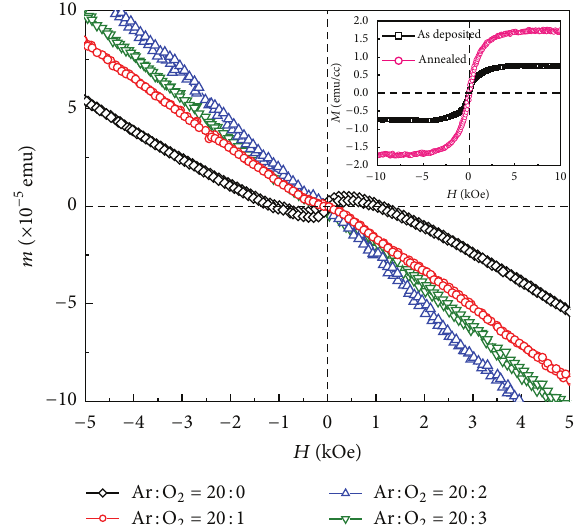
Figure 4: 𝑀 - 𝐻 curves for ZnO thin films deposited under different oxygen partial pressure at 300 K. Upper inset: 𝑀 - 𝐻 curves of ZnO as-deposited and annealed films deposited under 𝑃 after the subtraction of the diamagnetic